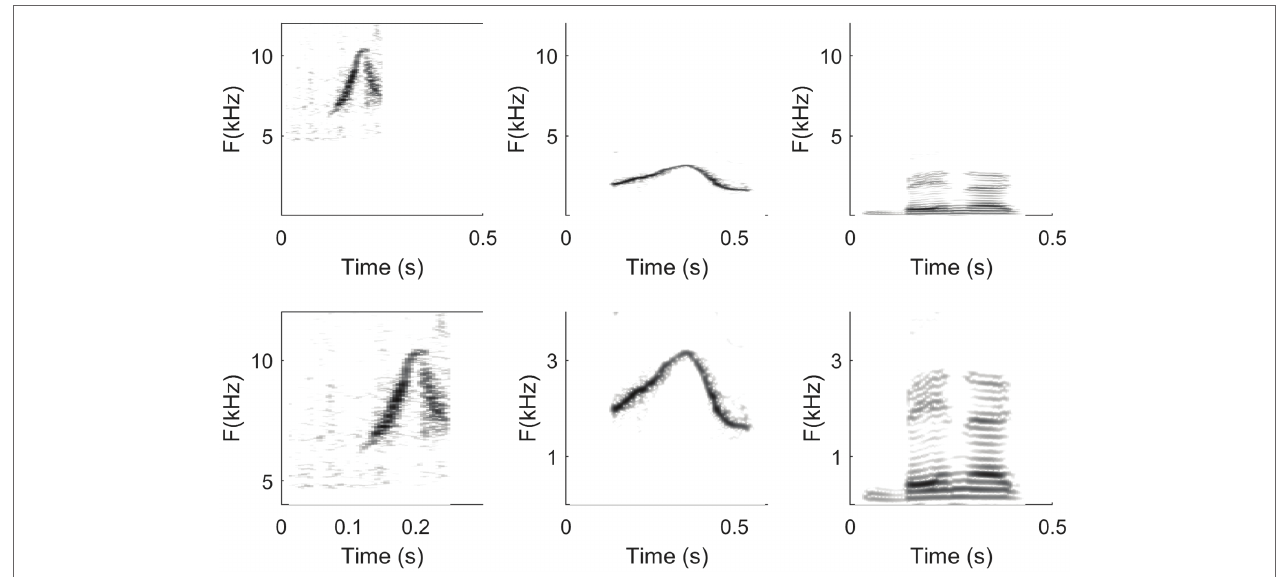
FIGURE 4 | Spectrograms of a dolphin whistle (left column), a human whistled utterance (/bena/; middle column), and a spoken utterance (/bena/; right column) represented at two different scaling levels (upper line vs. lower line). The first row highlights differences in signal types (dolphin whistle vs. whistled speech vs. spoken speech), whereas the lower row highlights well similarities in the relative variations of frequencies. Scales in the upper line have the same x and y (for all three columns). In the lower row, the representation is zoomed differently in x and/or y according to the most representative frequencies of each signal